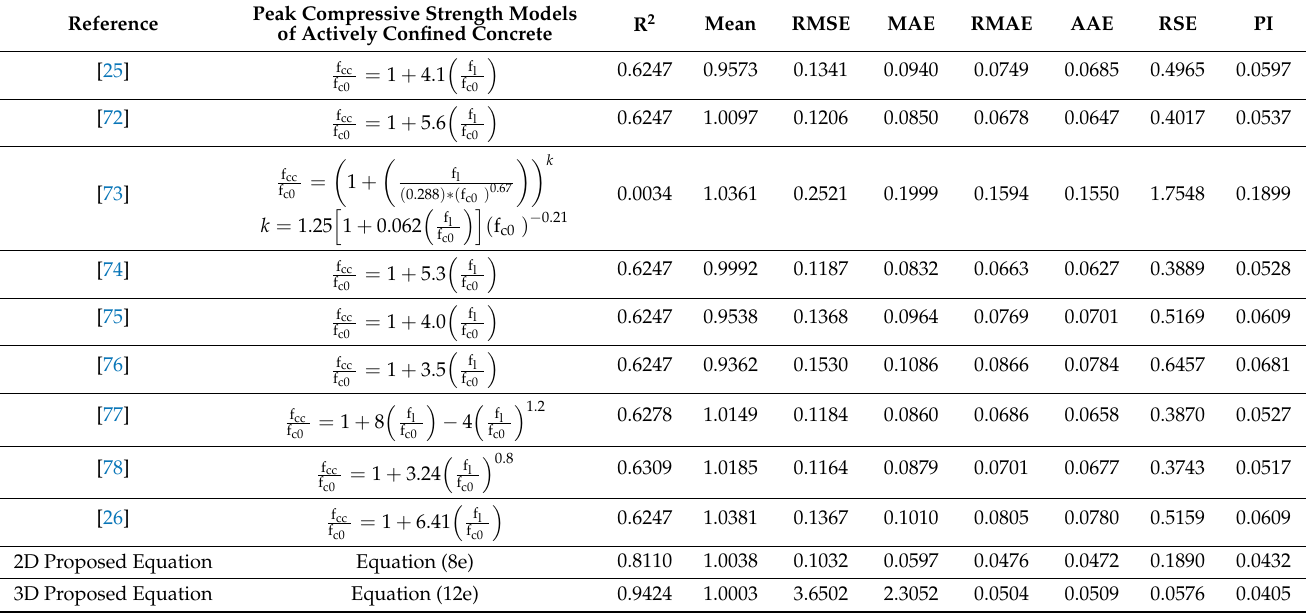
Table 13. Statistical indicators of the peak compressive strength models of actively confined